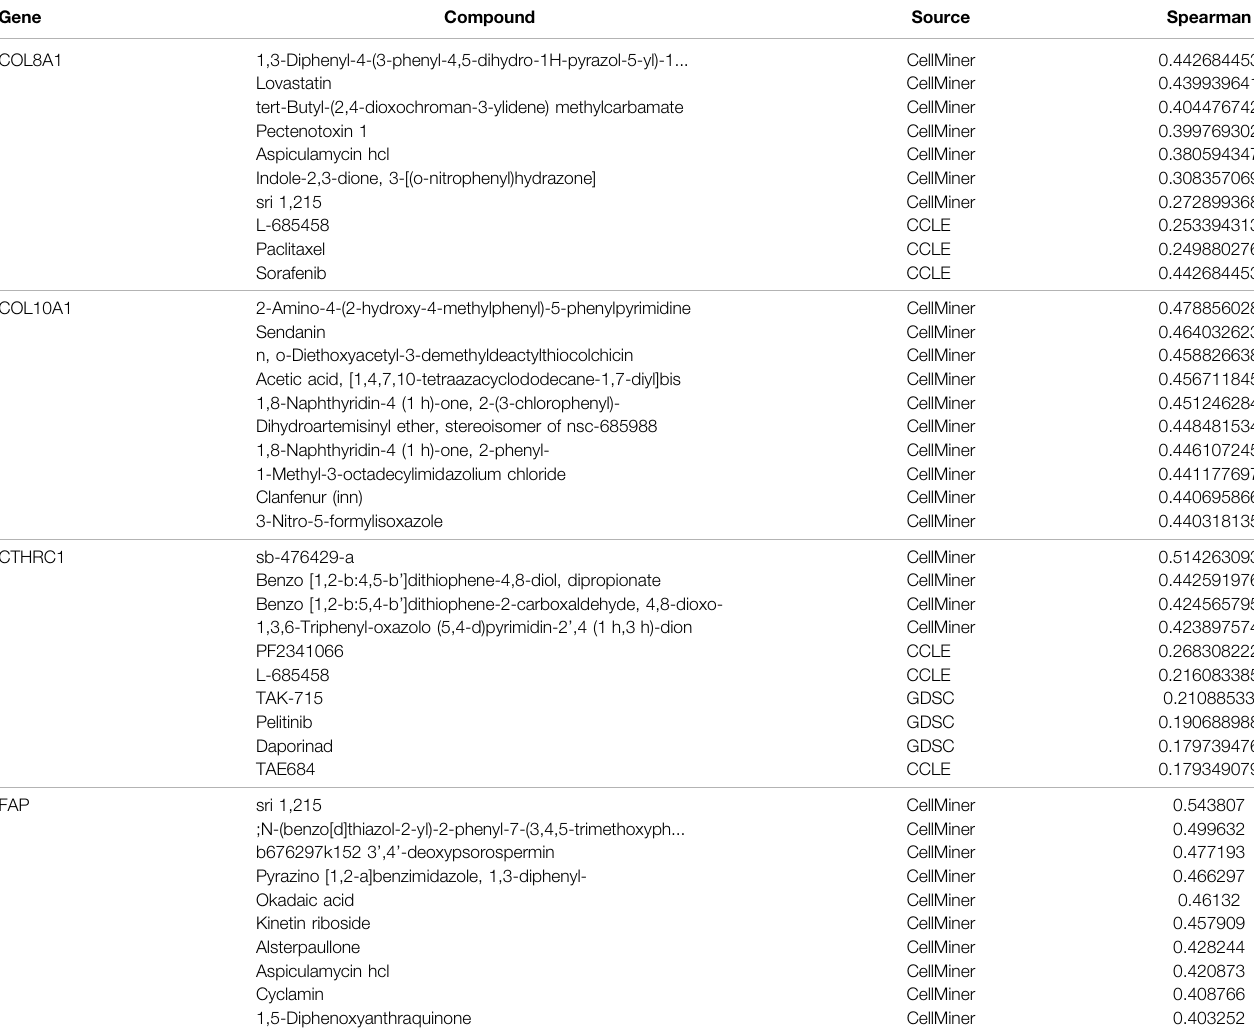
TABLE 2 | Top ten drugs associated with COL8A1, COL10A1, and CTHRC1 at expression level.